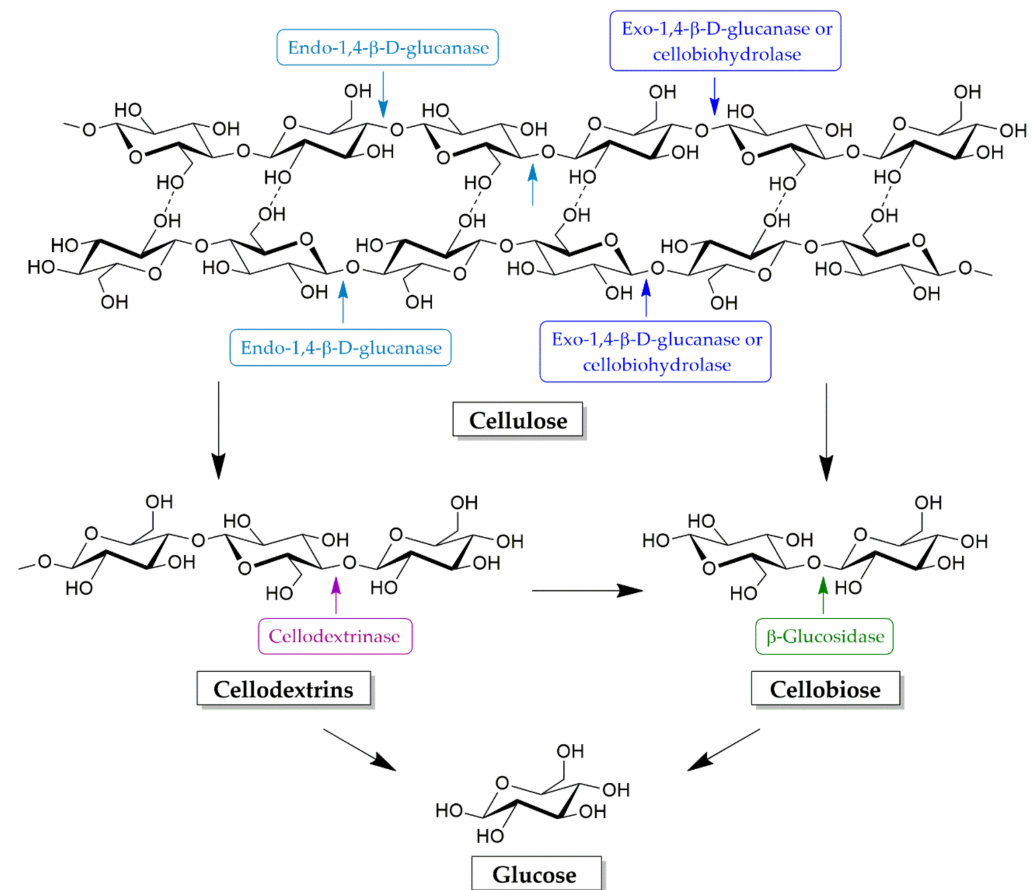
Figure 5. Enzymes involved in cellulose